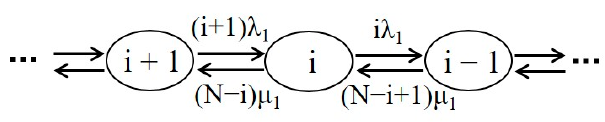
Figure 2. State transition diagram of Group 1 at state i.